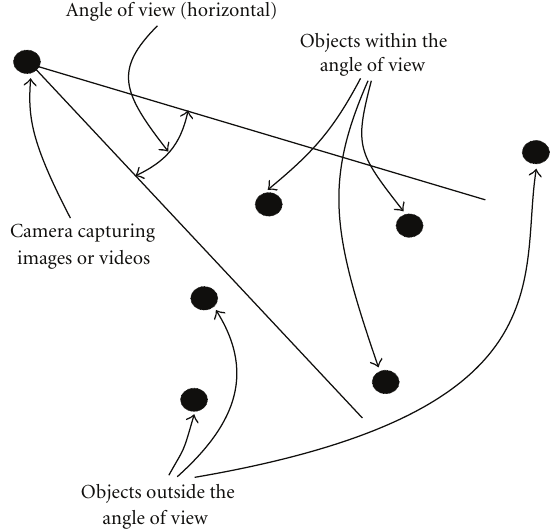
Figure 9: Detection of in-view cameras (view from the